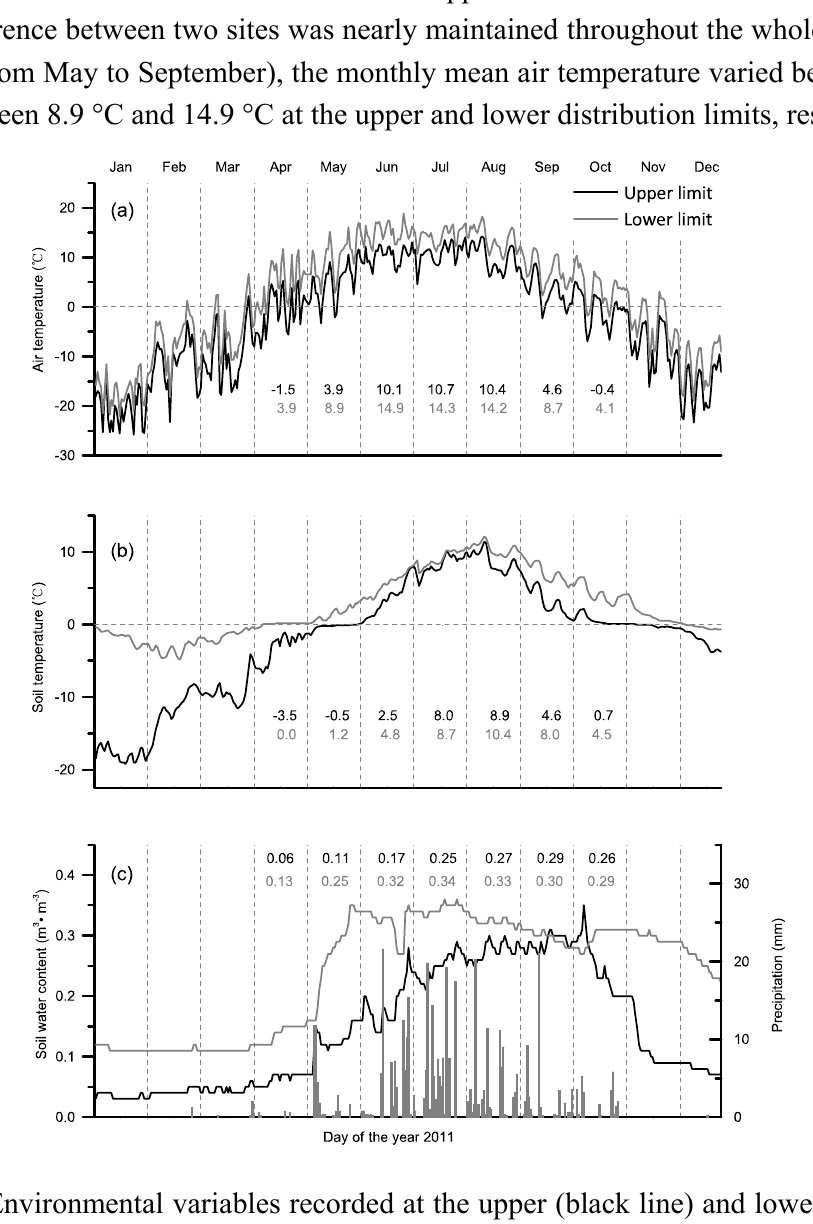
Figure 4. Environmental variables recorded at the upper (black line) and lower (grey line) distribution limits in the year of 2011, including the mean daily ( a ) air temperature, ( b ) soil temperature, ( c ) soil water content and daily precipitation sum (grey bar). ( a–c ) The mean monthly values are denoted by black and grey colors for the upper and lower distribution limits,